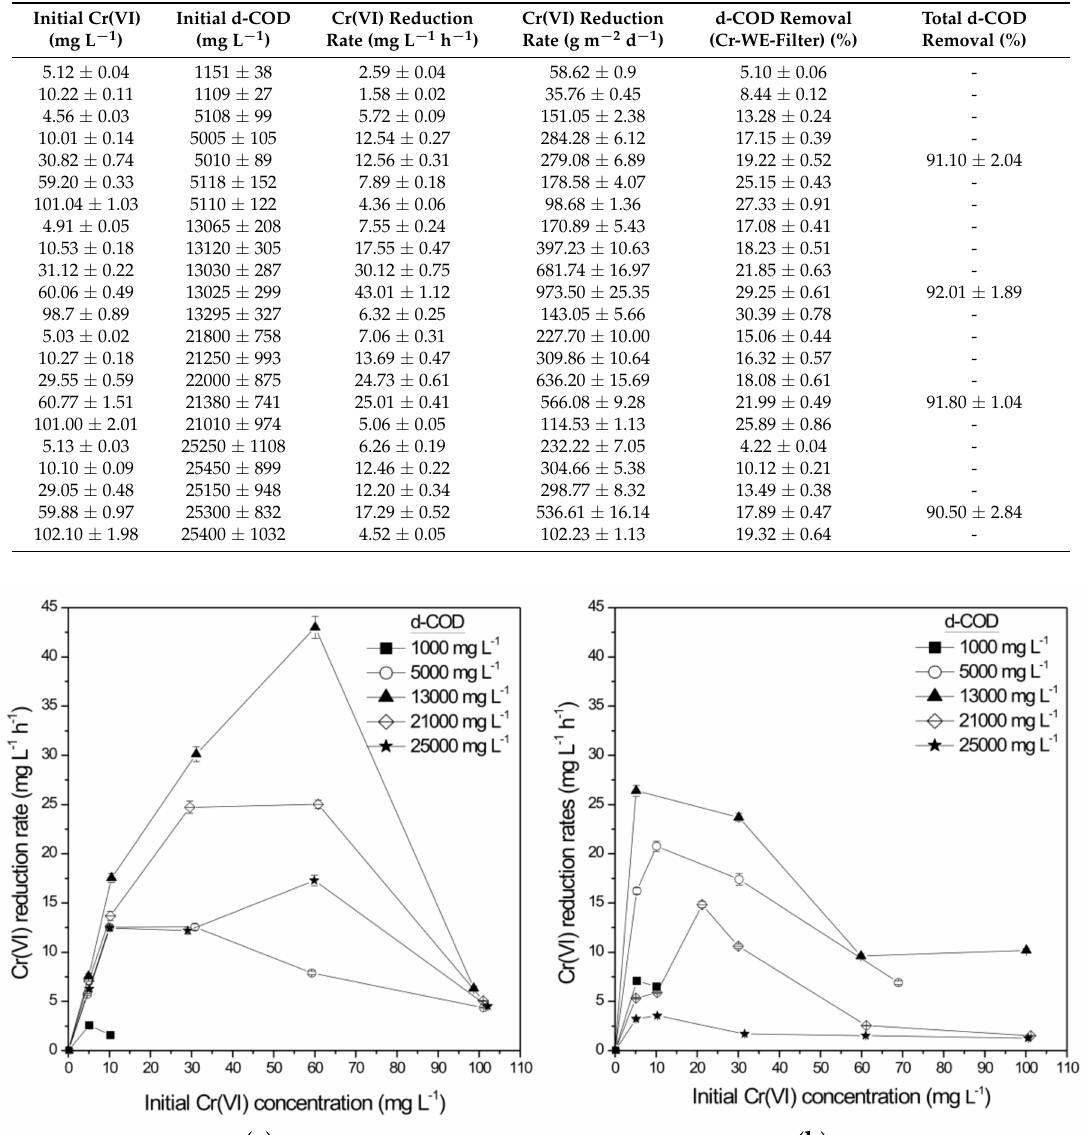
Table 2. Cr(VI) reduction and d-COD removal rates for the different initial Cr(VI) and d-COD concentrations tested in the Cr-WE-filter operating under SBR with a recirculation rate of 0.5 L min − 1 .